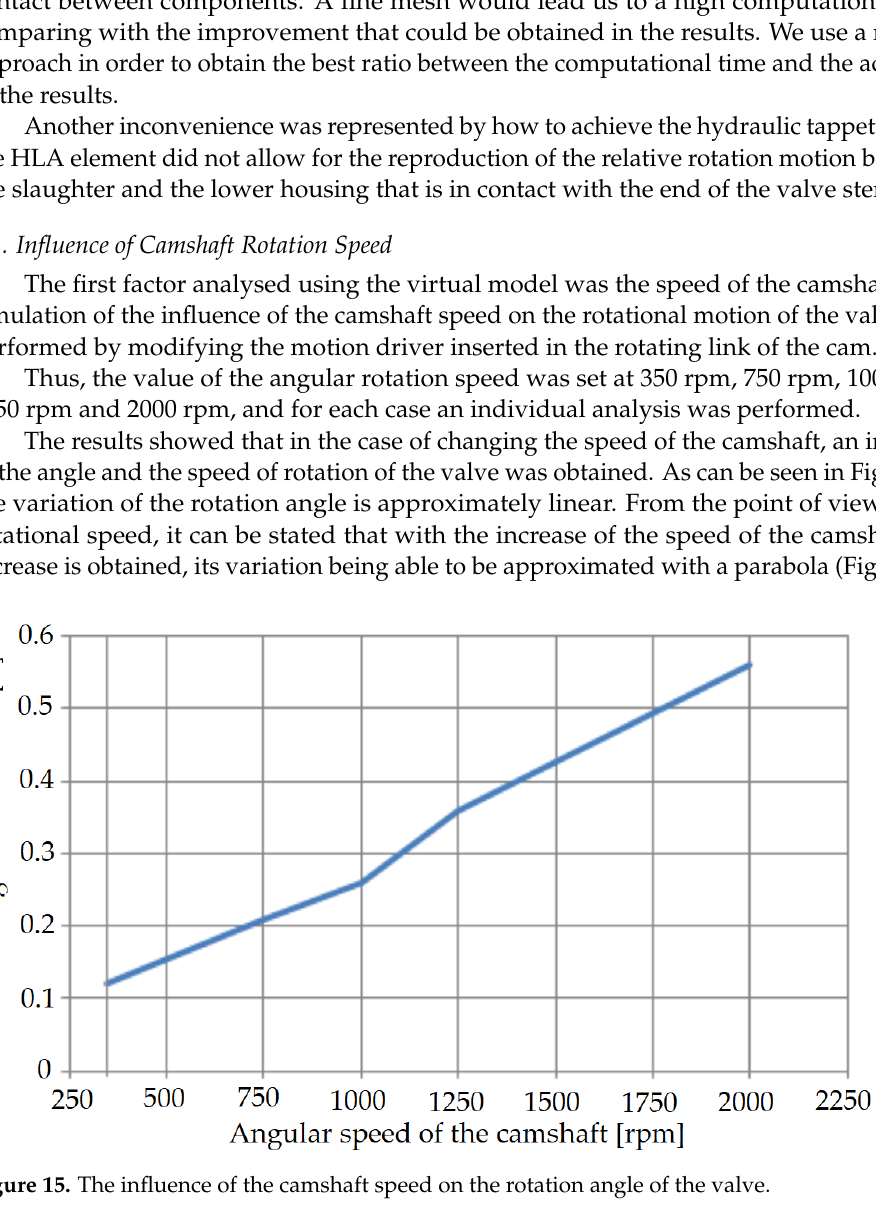
Figure 16. Influence of camshaft speed on valve rotation speed. So, by increasing the speed of the camshaft, an increase in the rotation angle of the valve was obtained without respecting the linearity. This was mainly due to the contact between the cam and the cleat, with sliding and rolling, but also to the slip that occurred when transmitting the moment from the cleat to the valve. 3.2. Influence of Friction Coefficient As modelling in the virtual environment using LMS Virtual Lab v.10 [49] did not allow for the definition of the lubrication type and lubricant properties, in order to